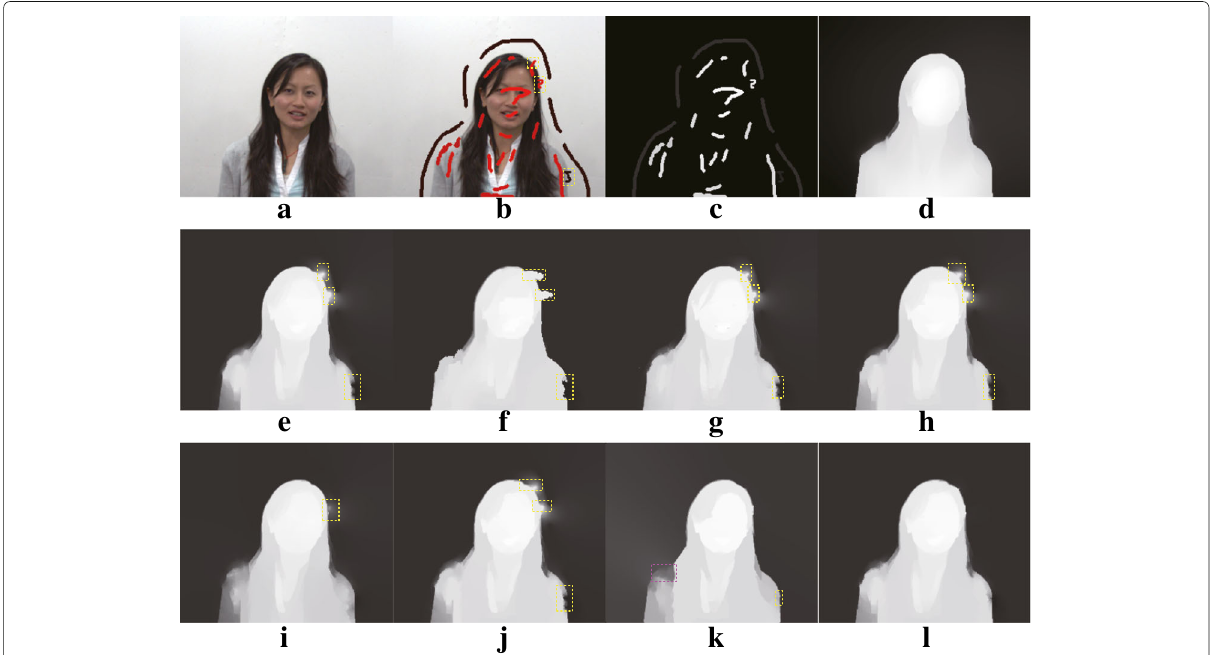
Fig. 6 Results of RGBZ_03 with cross-boundary input. a Input image. b User-labeled image. c Sparse depth. d Groundtruth depth. e Depth of RW. f Depth of HGR. g Depth of NRW. h Depth of OPT. i Depth of OCP. j Depth of SDF. k Depth of (cid:2) 1 . l Depth of the proposed method. Please zoom in to see details